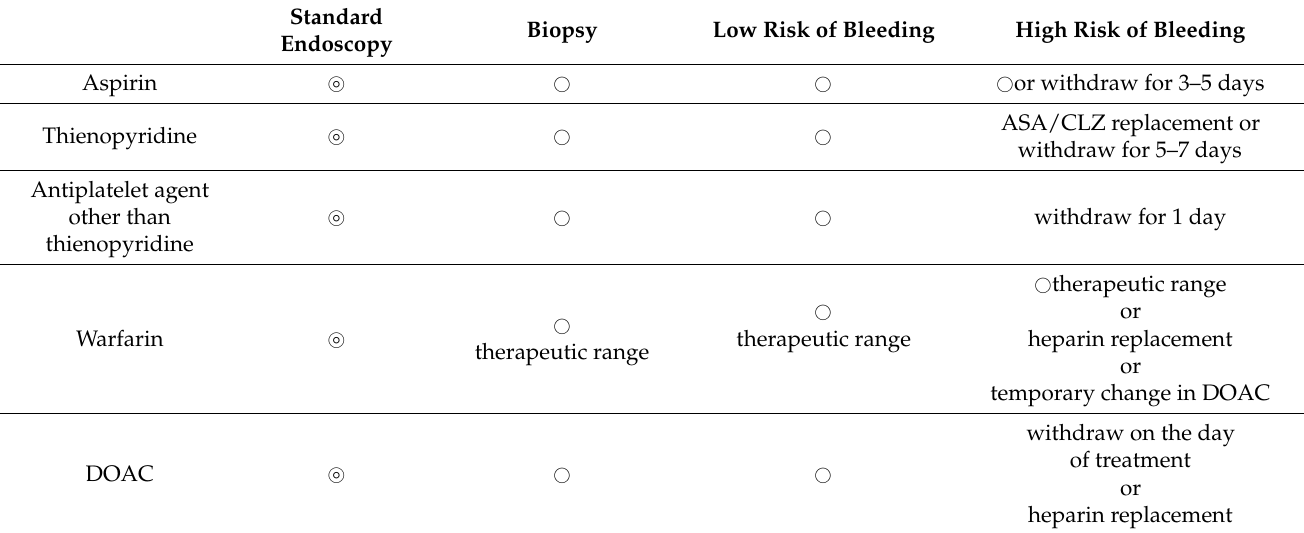
Table 1. Withdrawal of monotherapy with antiplatelet agents or anticoagulants during gastroenterological endoscopy.